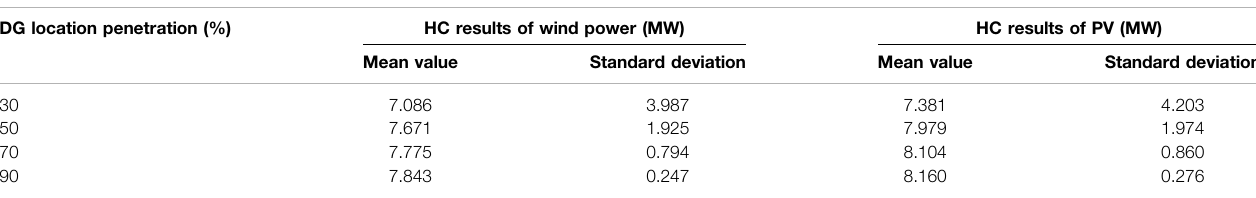
TABLE 3 | Statistical results of HC with different penetration levels. DG location penetration